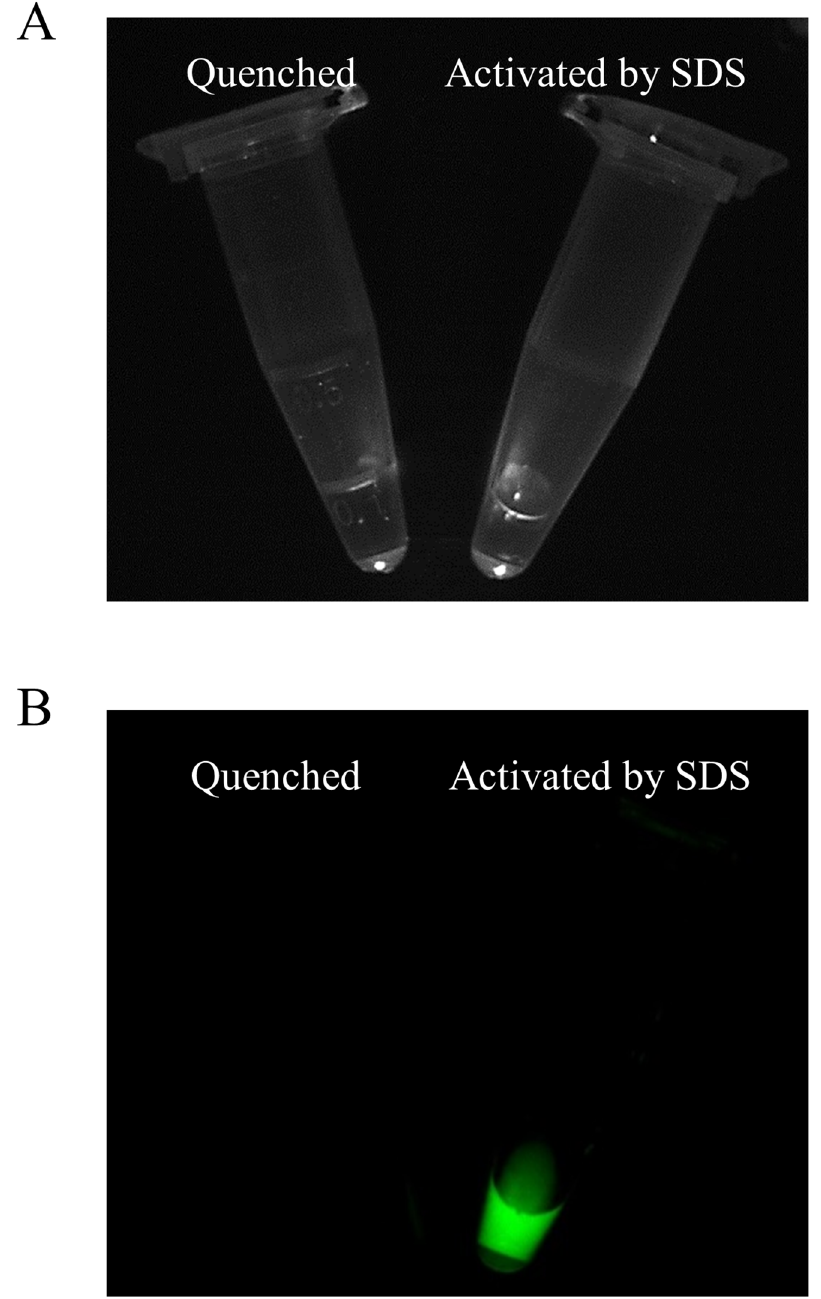
Fig 1. Quenched (left) and chemically dequenched (right) Pan-ICG. (A) White image (B) Fluorescence image. Dequenched conjugates showed increased fluorescence signals as shown in green.